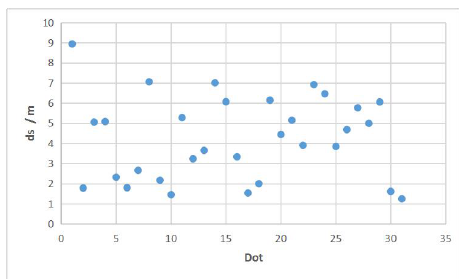
Figure 3. Errors of plane accuracy in field 1